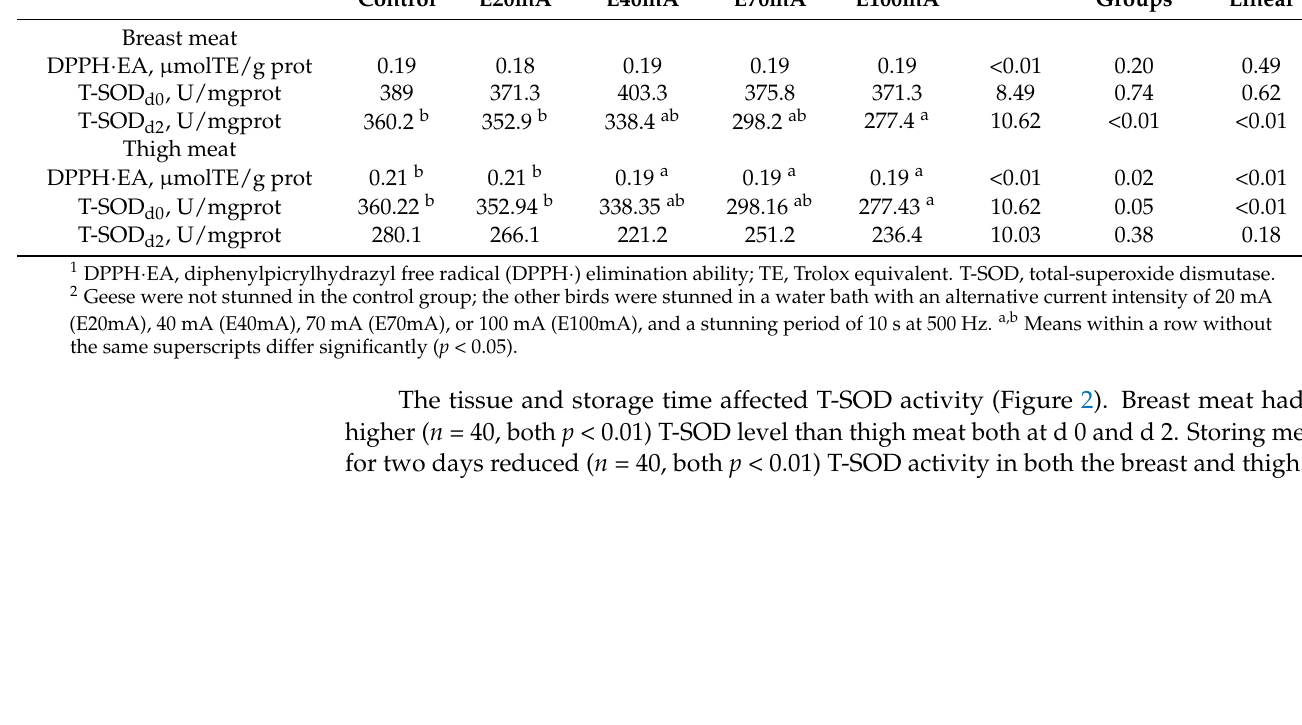
Figure 1. Effects of tissue and storage time on malondialdehyde (MDA) concentration. Means with no common superscripts between storage times (a, b) or tissues (X, Y) differ significantly (all p < 0.01). in Table 4. Stunning geese with increasing current intensity linearly reduced DPPH · elimination ability, the enzyme activity of T-SOD d2 in breast meat and T-SOD d0 in the thigh meat of geese (all p < 0.01). Stunning geese with 20 mA resulted in higher ( p = 0.02) DPPH · EA in thigh meat, higher ( p < 0.01) T-SOD d2 in breast meat and higher ( p = 0.05) T-SOD d0 in thigh meat compared with 100 mA. Table 4. Effect of electrical current intensities on DPPH · EA and T-SOD activity in goose meat at 0 to 2 days postmortem. Items 1